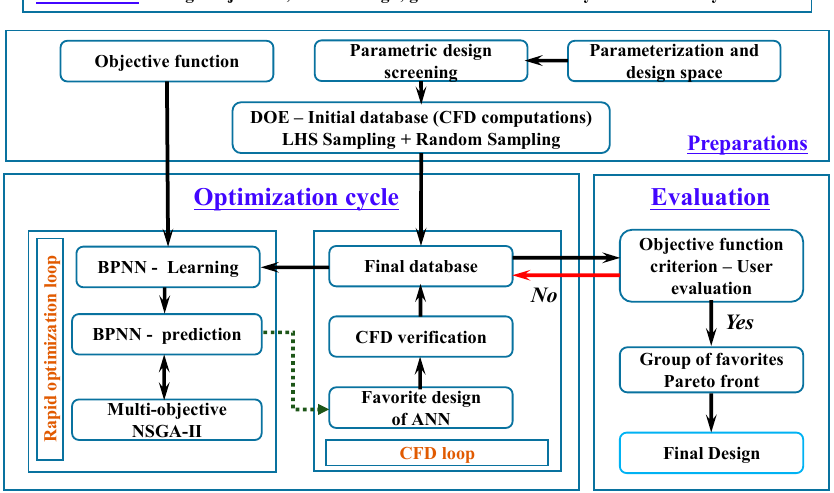
Figure 4. Flow chart of the design optimization system.